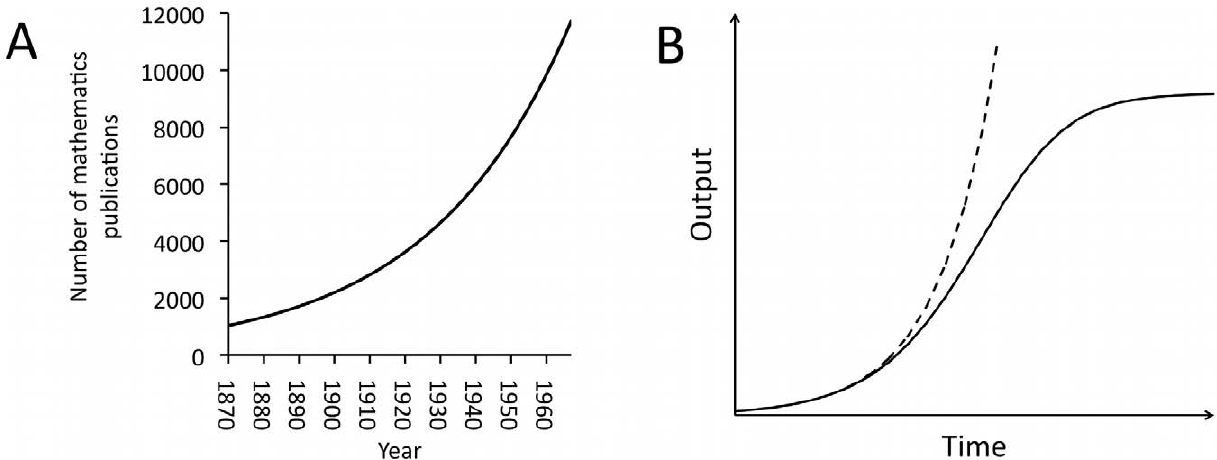
Figure 1. Exponential growth in scientific knowledge. (A) Empirically-derived exponential growth in mathematical knowledge as measured by the number of published abstracts in mathematics from 1868–1965. The curve shown is a best-fit to data reported in May [17], regression equation n=1400e 0.025(t-1880) . (B) Price [12] argues that exponential increases in scientific output such as those documented by May (dashed line) are actually the initial part of a logistic growth rate (solid line), eventually reaching a saturation point due to constraints on cumulative cultural evolution.